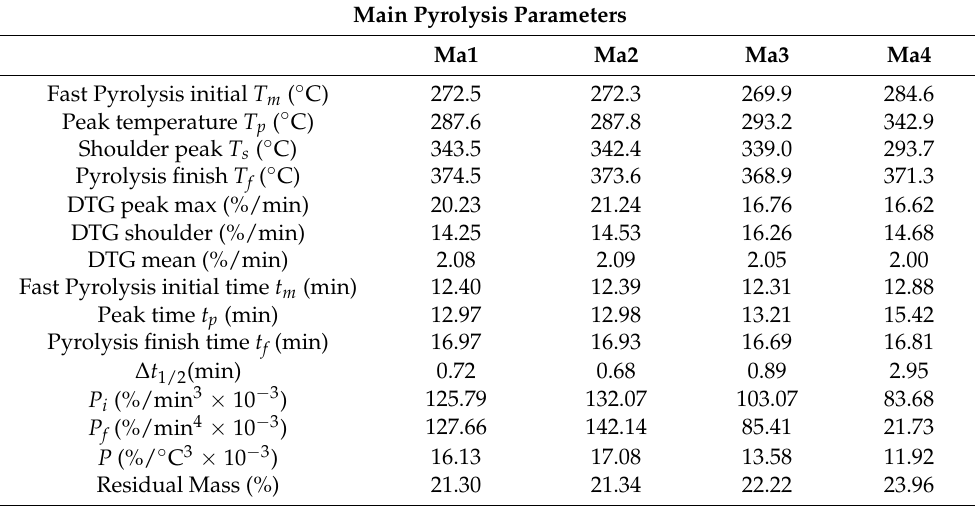
Table 3. Main pyrolysis parameters (inert